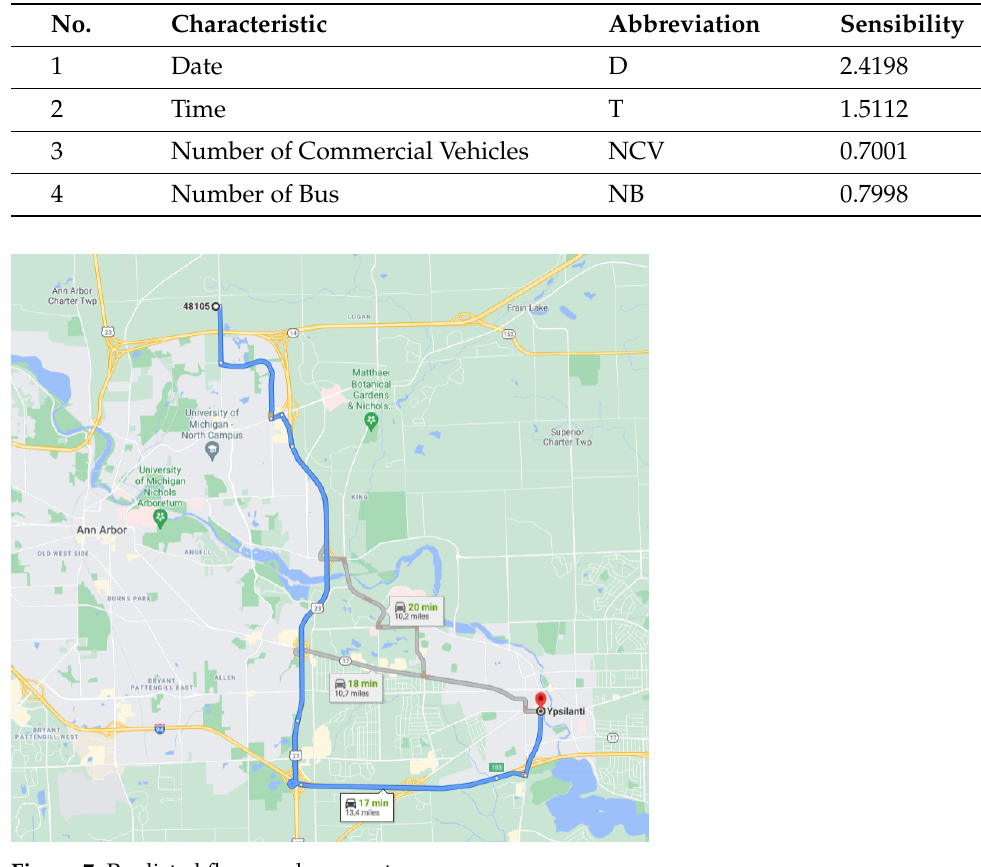
Figure 7. Predicted flow road segment.